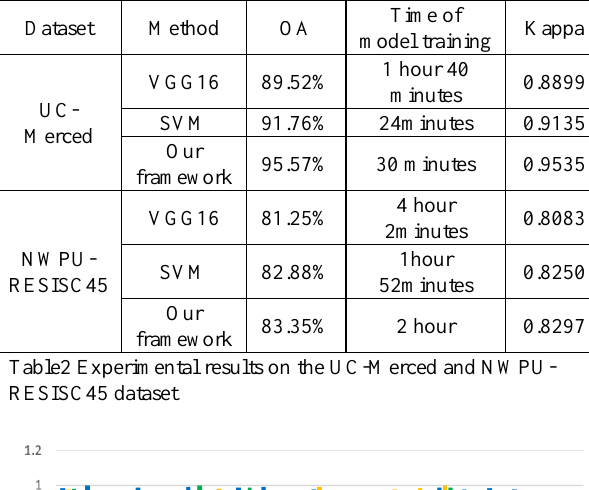
Figure 8 The confusion matrix of our framework’s performance on UC-Merced dataset.